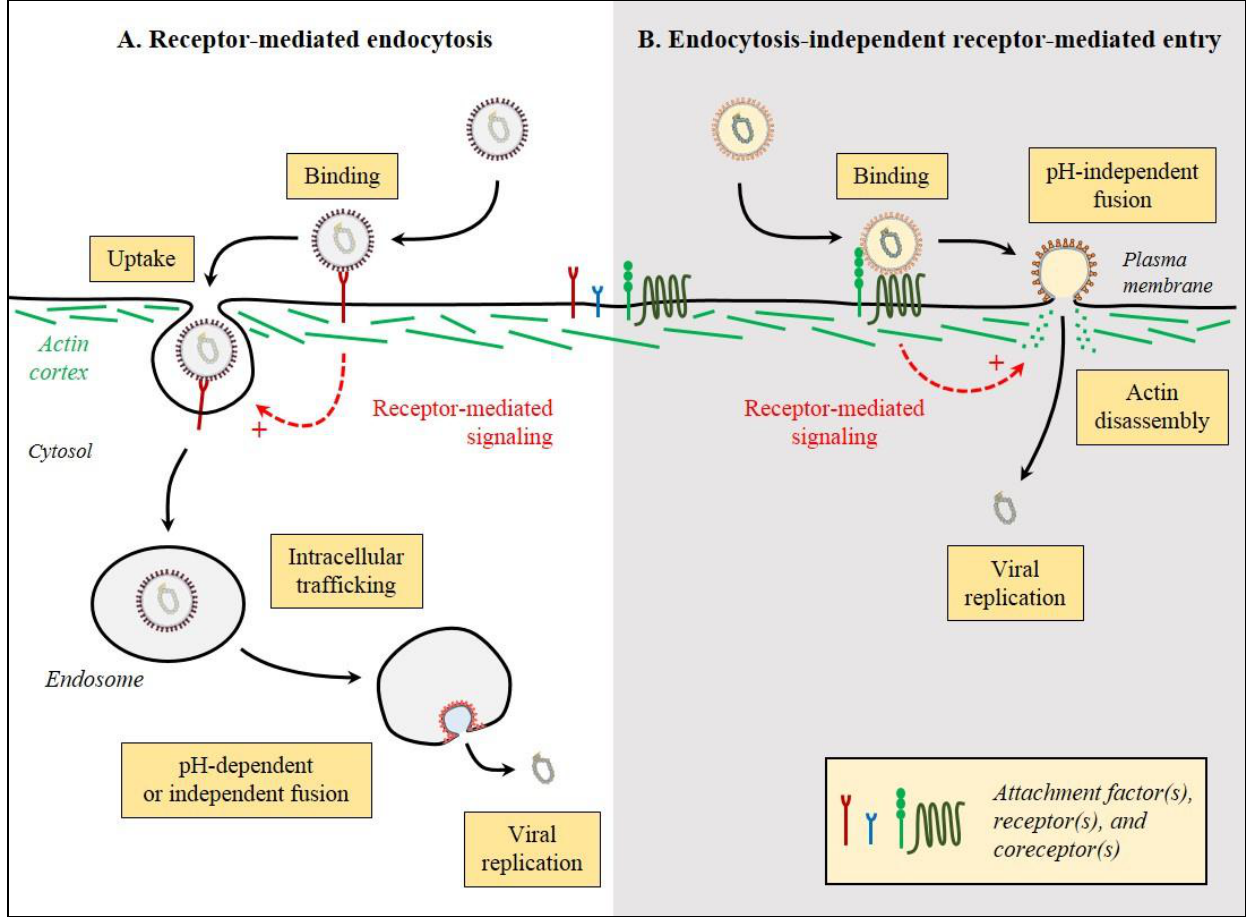
Figure 1. Strategies of virus entry. To gain access to the cytoplasm of host cells, viruses can employ two main strategies, i.e. , either ( A ) through endocytosis and escape from endosomal vesicles in a process referred as receptor-mediated endocytosis or ( B ) by direct penetration from the plasma membrane, referred as endocytosis-independent receptor-mediated entry. Enveloped viruses are shown; however non-enveloped viruses have evolved similar strategies. These are just generalizations and there are exemptions from these rules. Black arrows represent the sequence of events and dashed-red arrows the potential induced signaling.